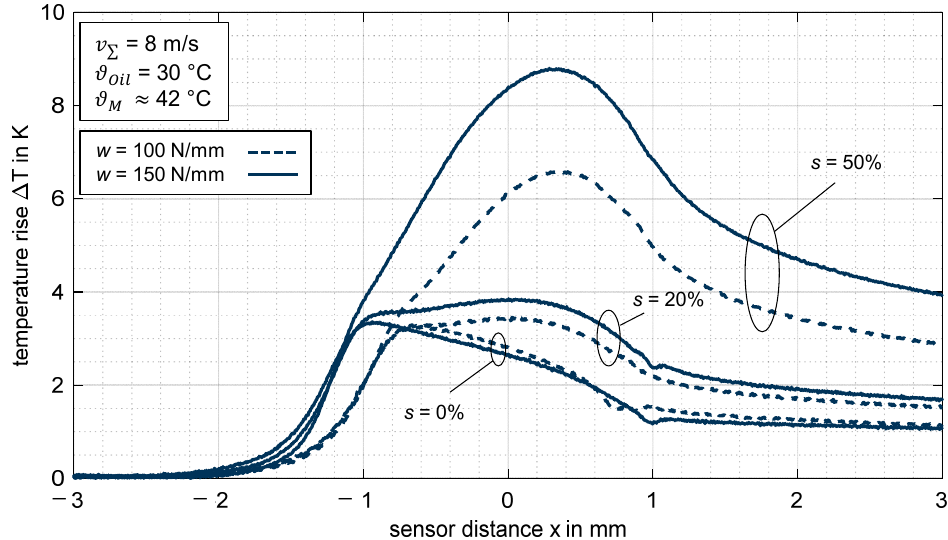
Figure 9. Temperature rise ∆ T for different line loads w = {100; 150} N/mm for the thermoplastic EHL contact ZrO 2 /PEEK (slip ratio s = {0; 20; 50}%, sum velocity v ∑ = 8 m/s, oil temperature ϑ oil = 30 ◦ C, MIN100).